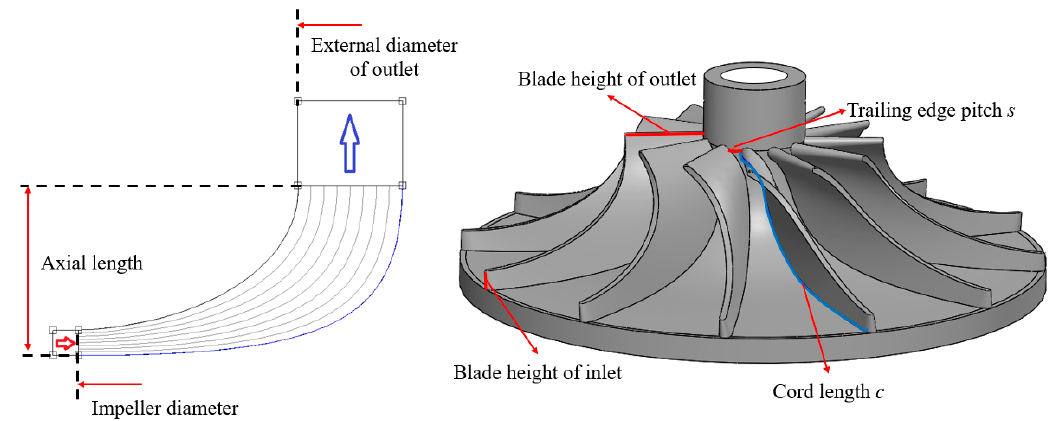
Figure 3. Geometry model of the impeller.